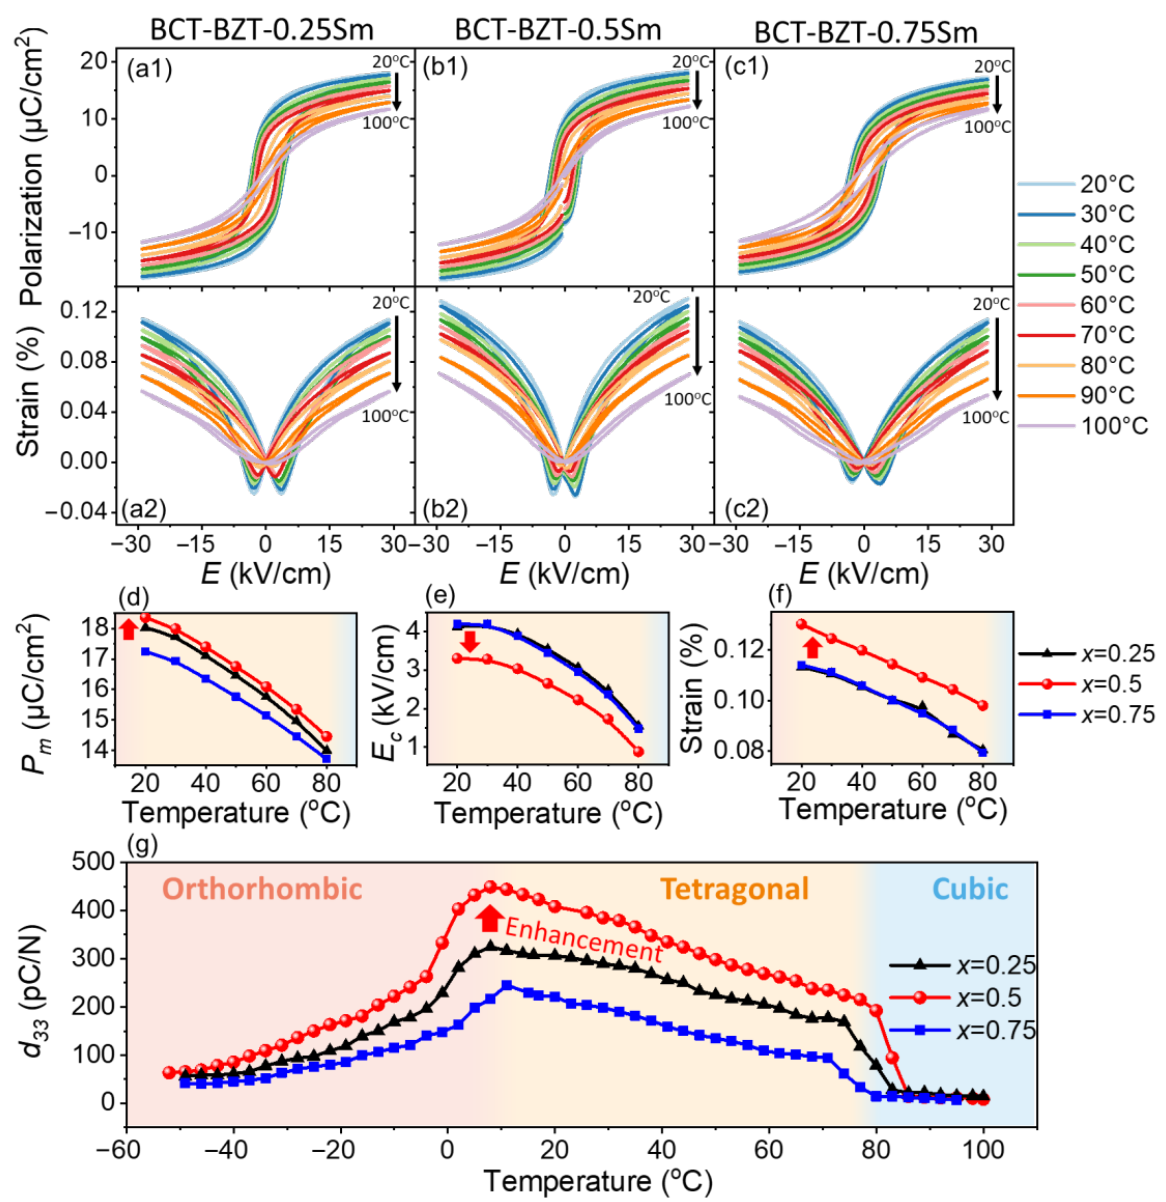
Figure 4. ( a1 – c2 ) The temperature-dependent polarization ( P )-electric field ( E ) loop and strain of the BCZT- x Sm ( x = 0.25, 0.5, 0.75) ceramics; temperature-dependent ( d ) maximum polarization ( P m ), ( e ) coercive field ( E C ), ( f ) strain, and ( g ) piezoelectric coefficient ( d 33 ) curves of the BCZT- x Sm ( x = 0.25, 0.5, and 0.75) ceramics.